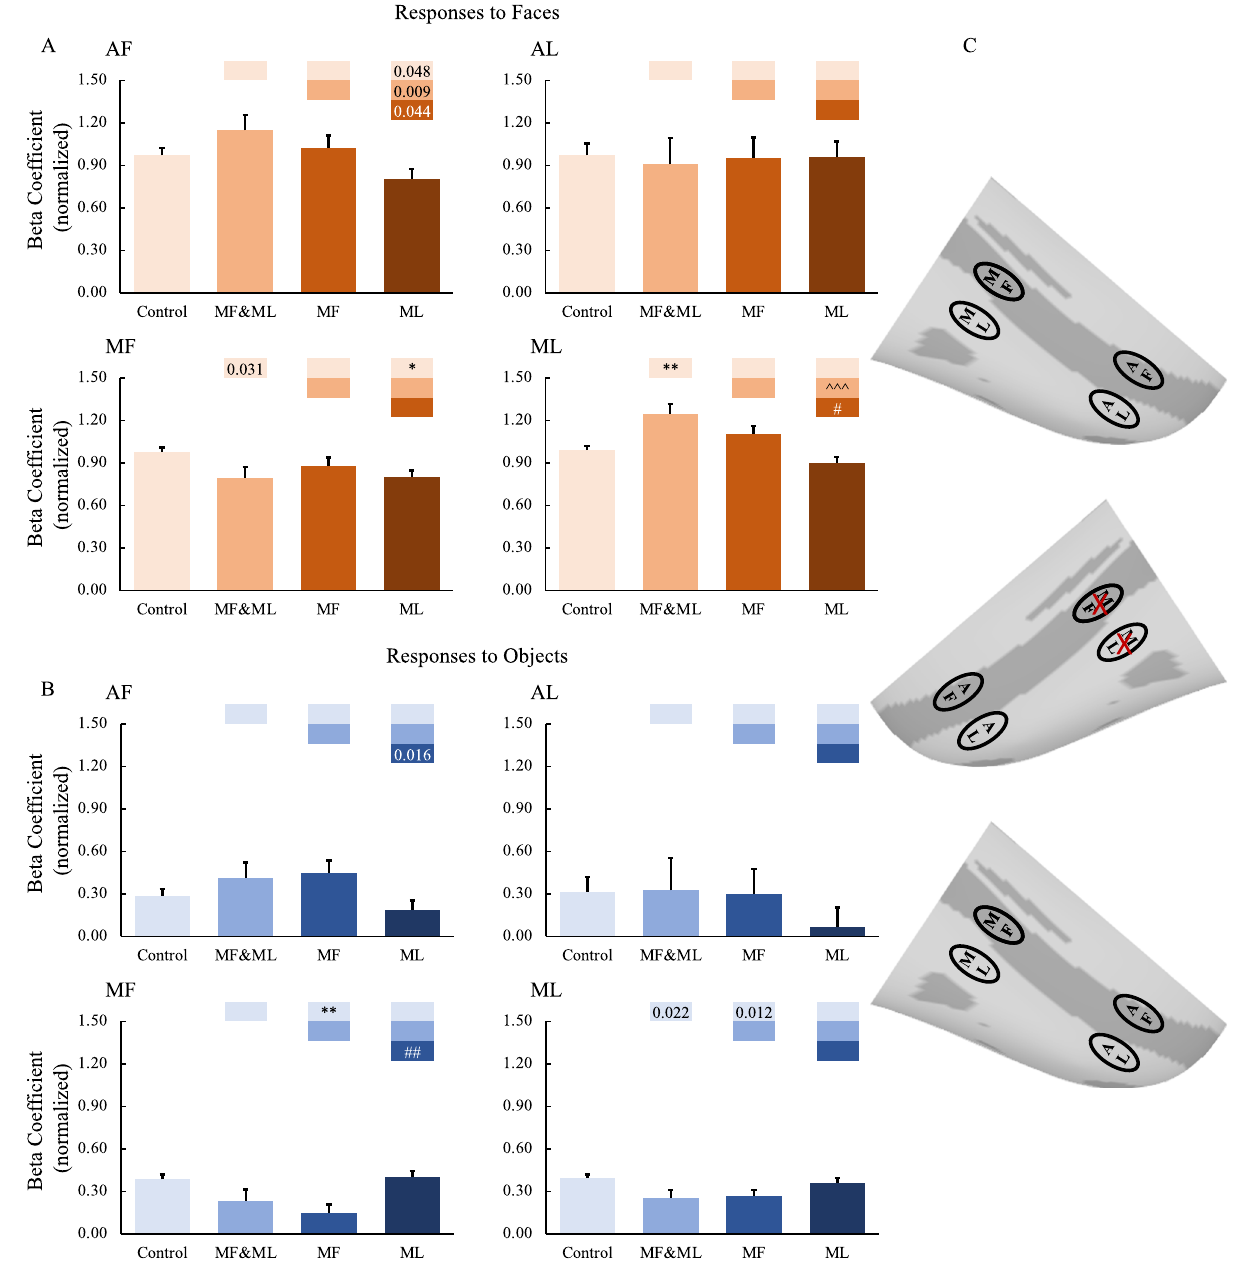
Fig. 3 | Effects of middle face patch inactivation on responses in the con- tralateraltemporalfacepatches.A , B Effectsofmiddlefacepatchinactivationon responses to faces and objects in the temporal face patches in the hemisphere contralateraltotheinactivationsitesacrossbothmonkeys.Boxplotsdisplaymean values±SEM. The name of the ROI is shown at the top left of each panel. MF&ML: combined MF and ML inactivation; MF: MF alone inactivation; ML: ML alone inac- tivation. Generalized Linear Mixed Models were performed for each ROI (AF, MF, and ML: n =664; AL: n =566) with Treatment and Hemisphereas fi xed factors, and Monkey (C and D), L-R hemisphere (Left and Right), Session, and Run as random factors. Post hoc testing was done with correction for multiple testing using the Holm-Bonferroni method. Color bars above a particular histogram contain the statistical results of comparing this inactivation condition and the condition to its